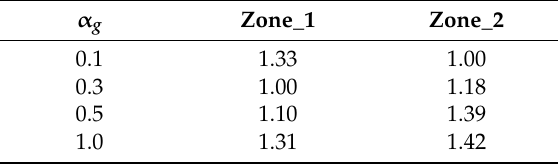
Table 9. q* values for MRSA ensuring the same NLTH